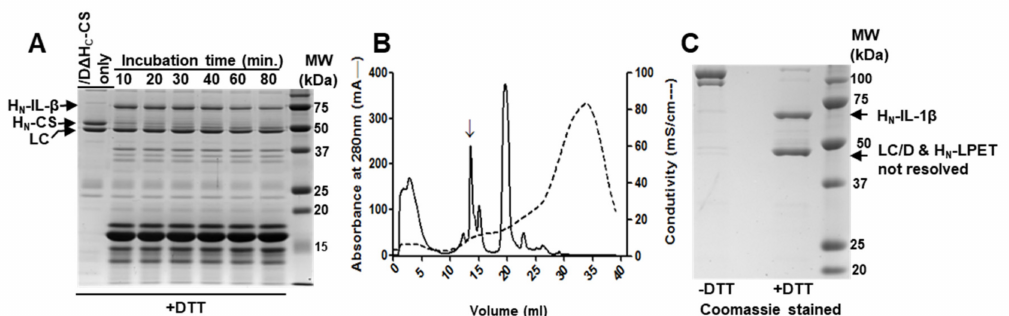
Figure 2. Production of / DIL-1 β . ( A ) D ∆ H C -CS was incubated with sortase A, and enterokinase cleaved Trx-H 6 -IL-1 β mixture at 37 ◦ C. Samples were taken at di ff erent time points and subjected to SDS-PAGE in the presence of 50 mM DTT followed by Coomassie staining. ( B ) Anion-exchange chromatography was used to separate / DIL-1 β conjugate from the unconjugated product and contaminants. Arrow indicates the eluted peak for / DIL-1 β . Solid line and broken line represent the absorbance and conductivity, respectively. ( C ) Pooled / DIL-1 β product from B was subjected to SDS-PAGE followed by Coomassie